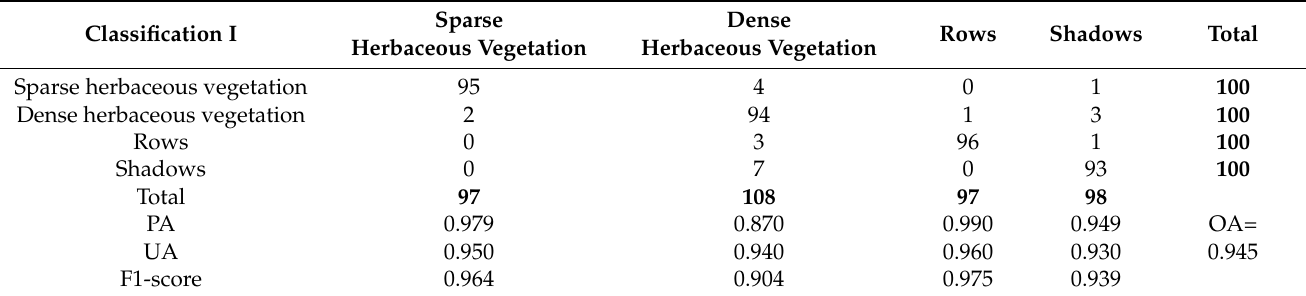
Table 4. Error matrix of classification I. PA = Producer’s Accuracy; UA = User’s Accuracy; OA = Overall Accuracy. Sparse Classification I Herbaceous Vegetation Sparse herbaceous vegetation